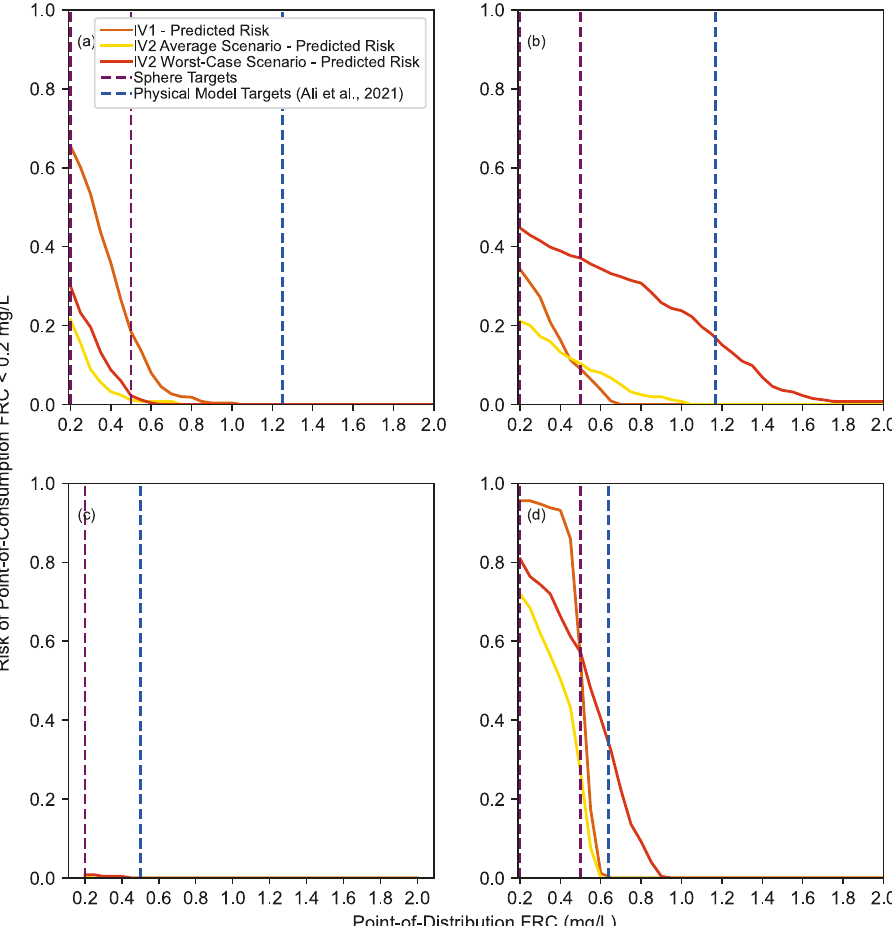
Fig. 7 Predicted risk of insuf fi cient point-of-consumption FRC (below 0.2 mg/L). The predicted risk is shown for a South Sudan, b Jordan (2014), c Jordan (2015), and d Rwanda. To achieve negligible risk, the ANN ensemble models recommend point-of distribution FRC between 0.65 and 0.90 mg/L in South Sudan, between 0.7 and 1.75 mg/L in Jordan (2014), between 0.2 and 0.4 mg/L in Jordan (2015), and between 0.60 and 0.90 mg/L in Rwanda. The upper limit of the recommendation for Jordan (2014) does not ensure negligible risk, as this was never achieved, but represents a plateau in the predicted risk of FRC below 0.2